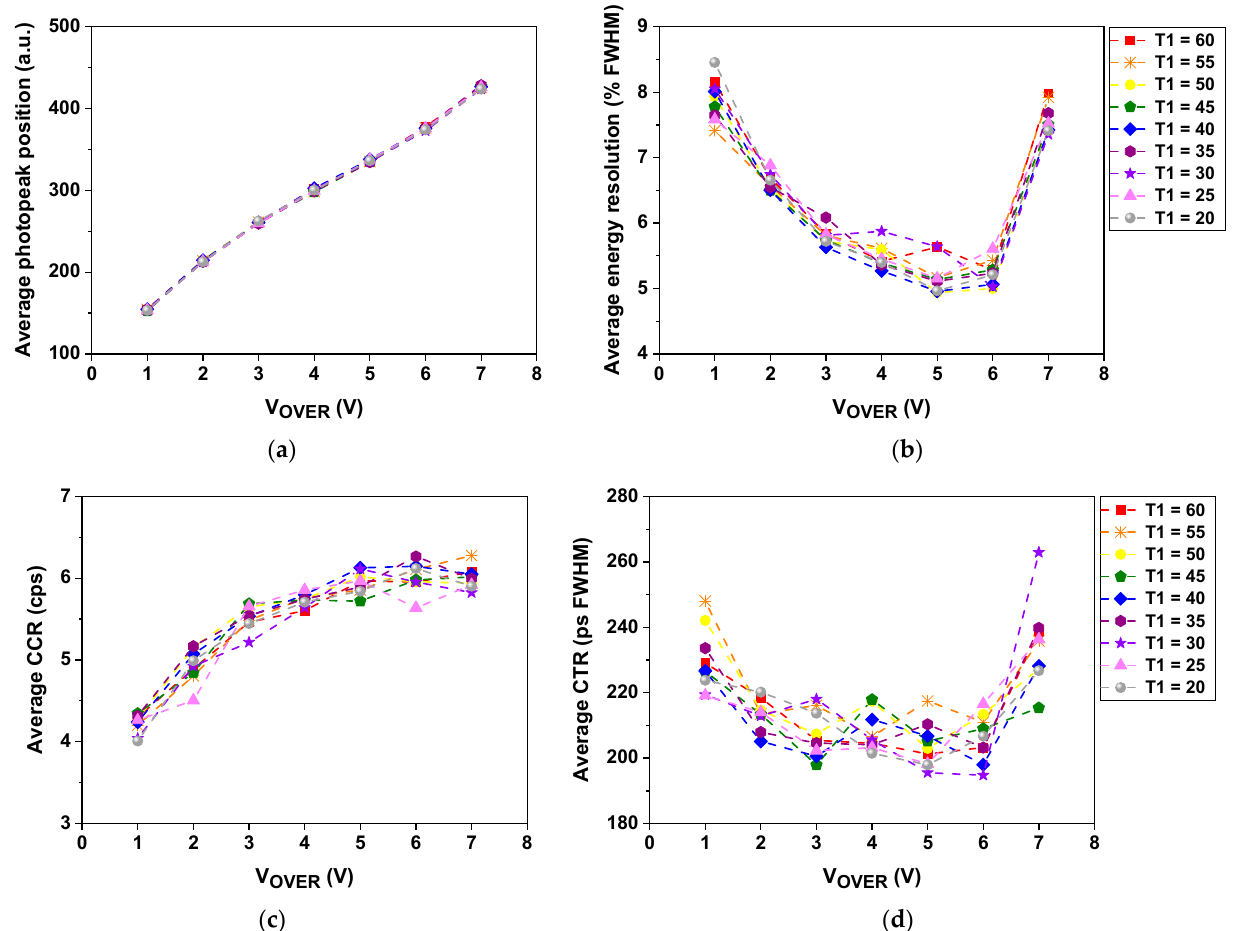
Figure 8. Average photopeak position ( a ), energy resolution ( b ), CCR ( c ), and CTR ( d ) measured using a pair of channels at different V OVER and T1 values.